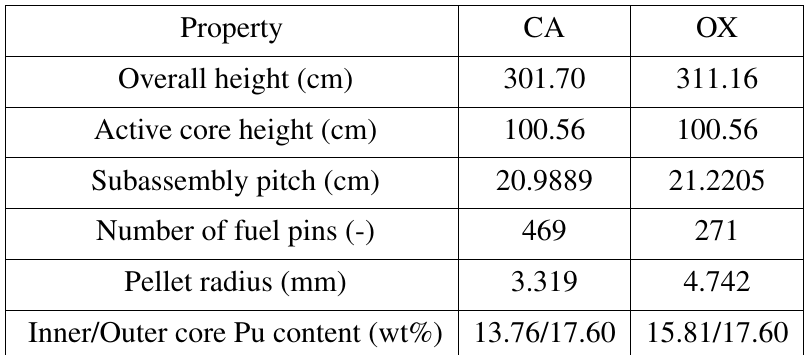
Table 1: Comparison of Core